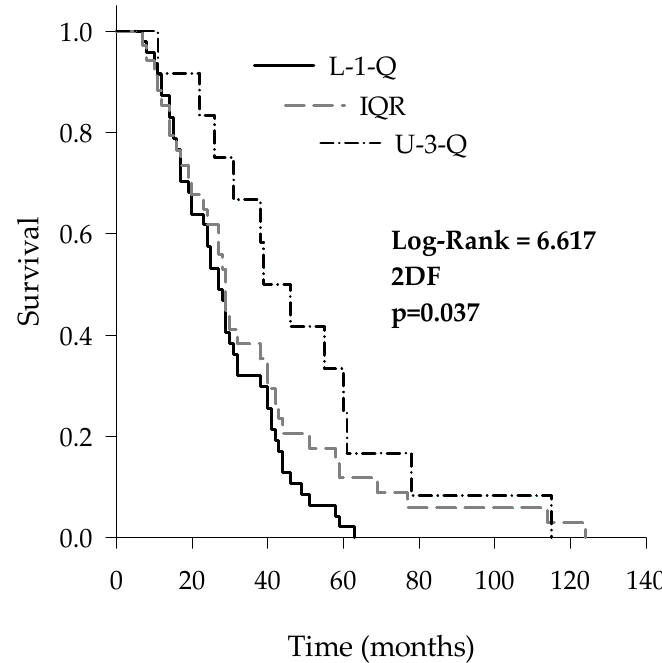
Figure 2. Kaplan–Meier survival curves of ALS patients stratified according to the median CSF values of the A β 42/40 ratio: lower than the first quartile (L-1-Q), interquartile range (IQR) and upper than the third quartile (U-3-Q) .